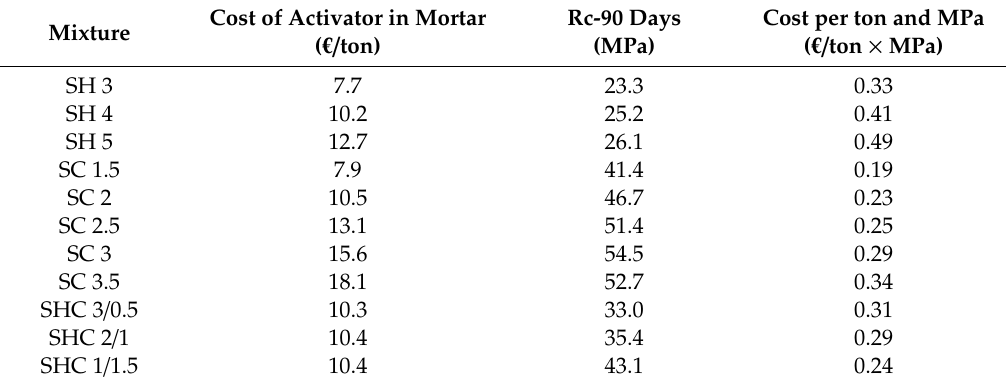
Table 6. Cost of the activator per mortar, 90-day compressive strength (Rc) and cost of the activator